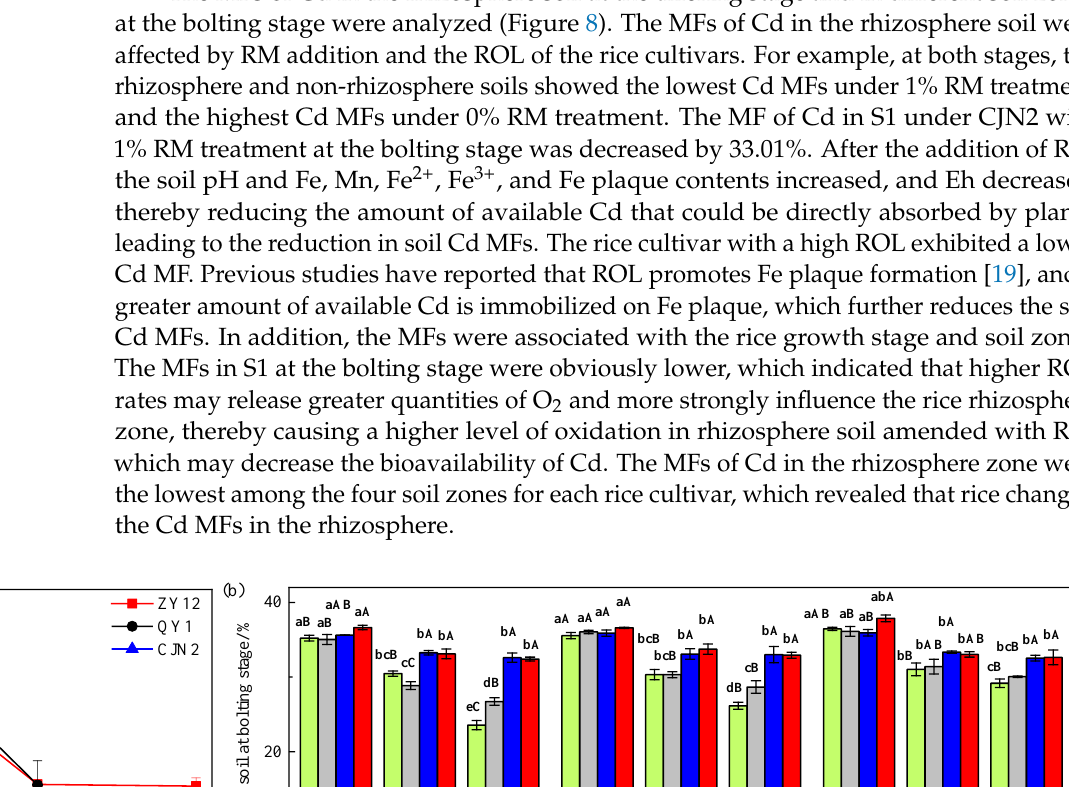
Figure 7. Effect of red mud (RM) on concentrations of Cd fractions in soil zones of rhizoboxes. ( a ) Cd concentration in F1; ( b ) Cd concentration in F2; ( c ) Cd concentration in F3; ( d ) Cd concentration in F4; ( e ) Cd concentration in F5. S1* indicates different soil zones in rhizoboxes at tillering stage; S1, S2, S3, S4 indicates different soil zones in rhizoboxes at bolting stage.